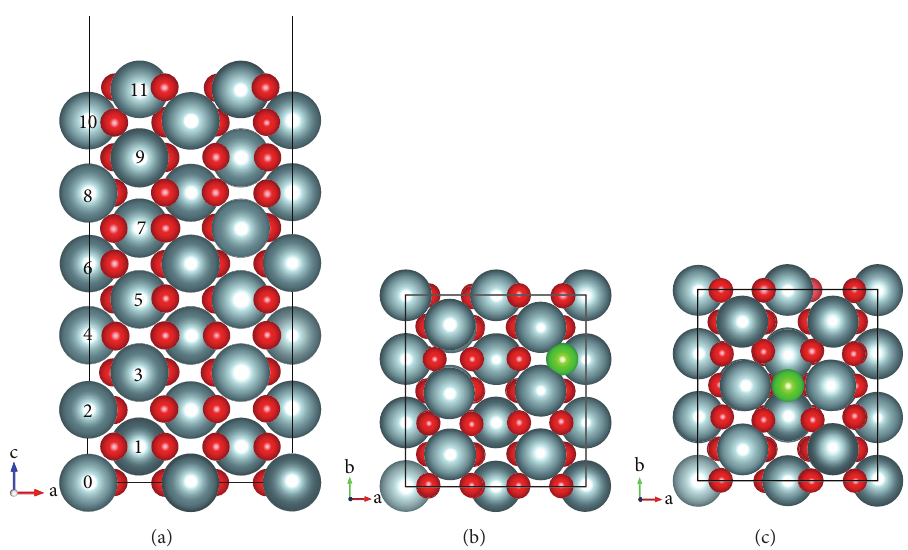
Figure 1:The slab structureof (a)pristinein thedirection perpendicular to the(110)surface, inwhich each layer isthestoichiometricUO 2 ; (b) O vacancy on the defective (110) plane corresponding to UO 1.833 ; and (c) O interstitial on the defective (110) plane corresponding to UO 2.167 . O atoms are shown in red color, U atoms in grey, and defects in green. The bottommost fixed bilayer is marked as layer of 0 and